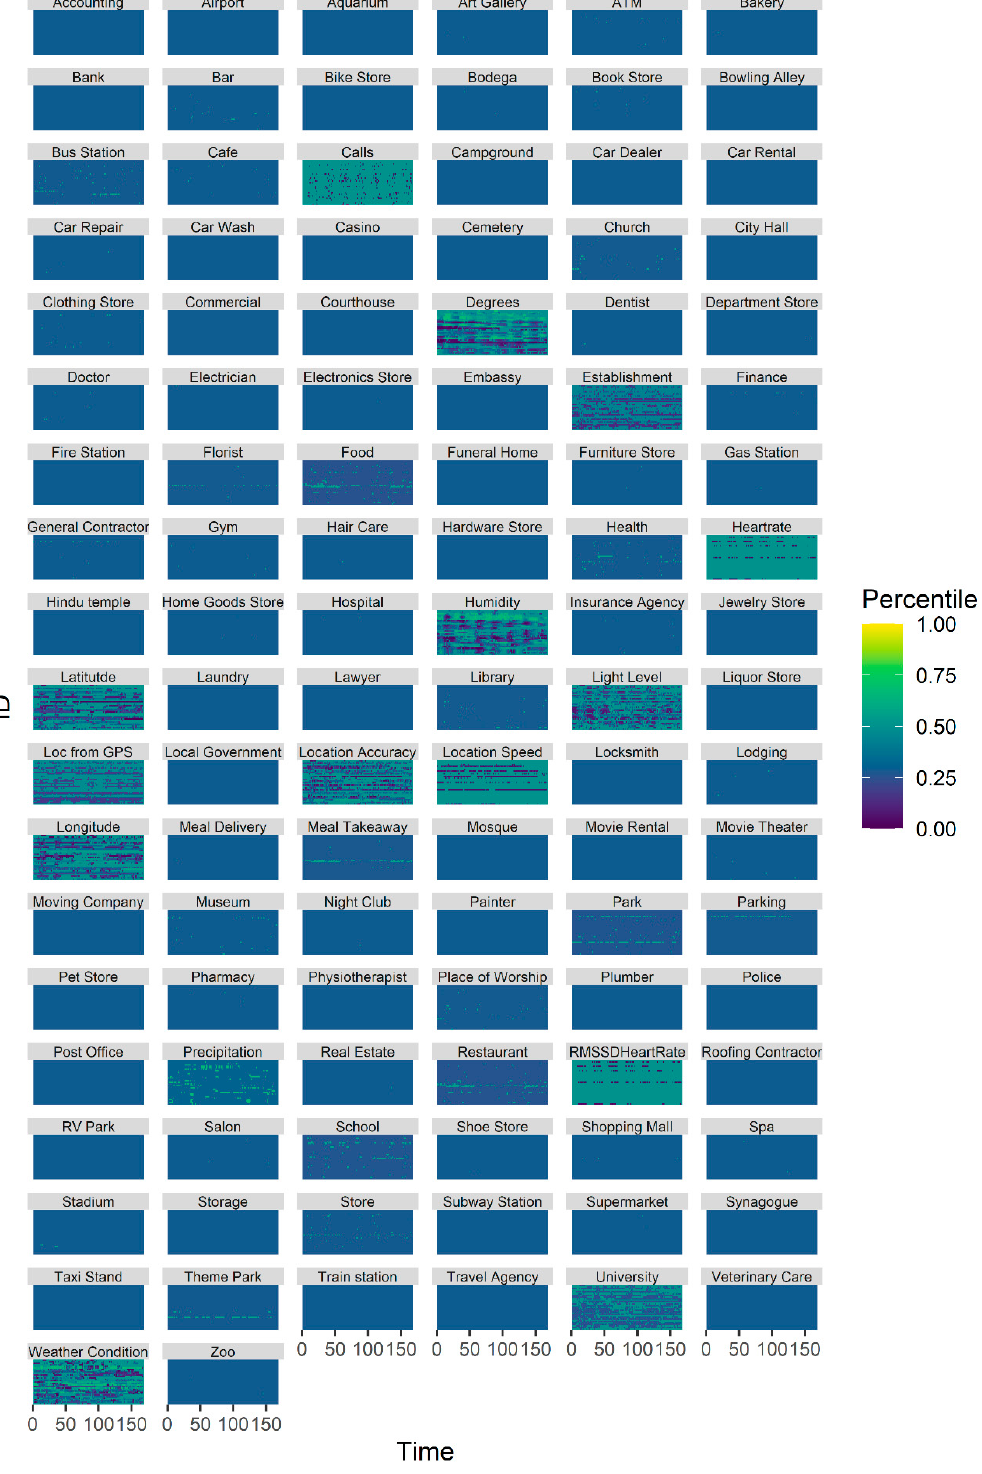
Figure 3. This plot depicts the percentile of the sensor values for each of the sensors across time for each subject.